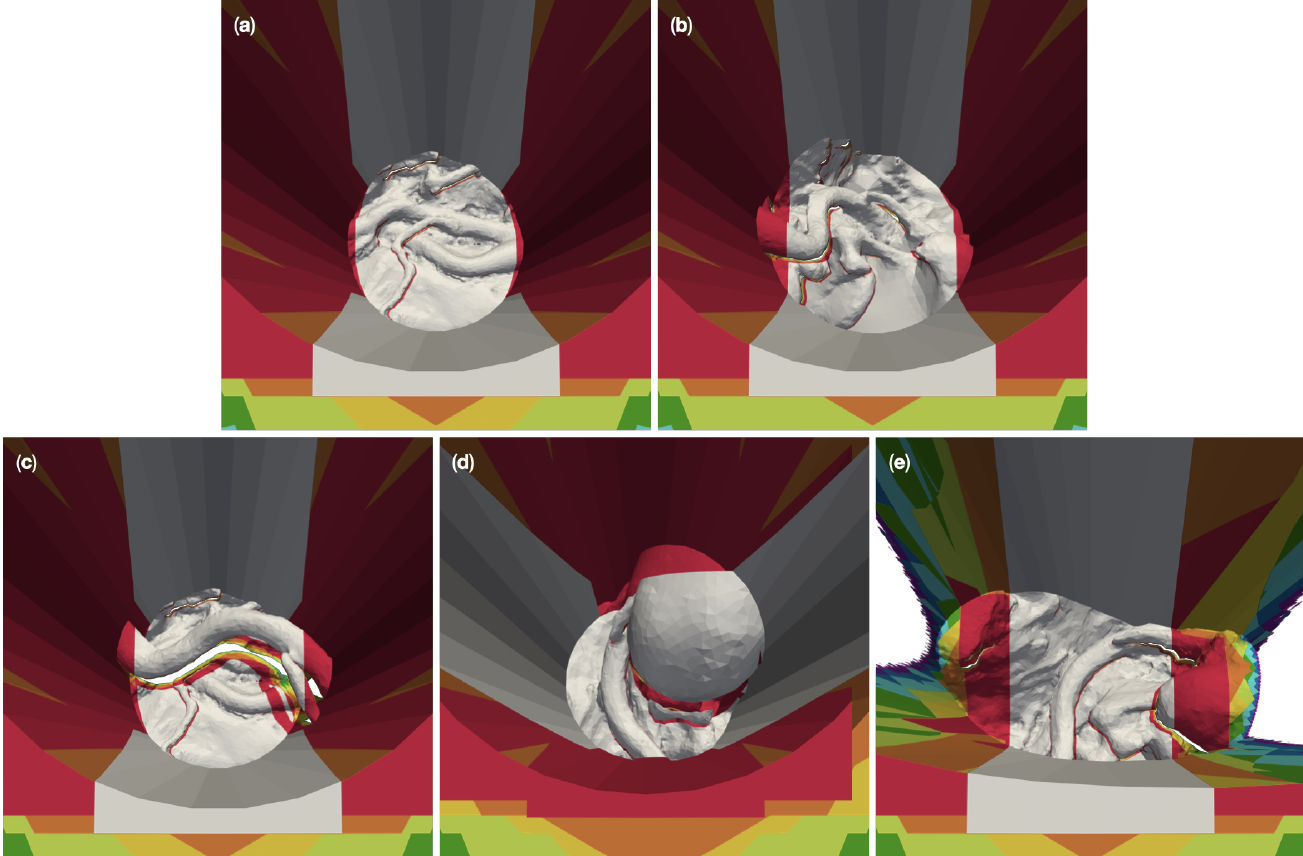
Figure 10. Overlay of zoomed plots of the 3D reconstructable surfaces of the five different 100mm-channel surgical site models for different camera numbers. The reconstruction with the largest area was placed in the background and the reconstruction with the smallest area in the foreground. The areas are color coded by number of cameras: Gray for two cameras, red for four cameras, orange for six, yellow for eight, lime for 16, green for 32, cyan for 64, blue for 128, purple for 256, and magenta for 360. ( a ) shows the reconstruction of “circ flat anatomy”. ( b ) does this for “circ angled anatomy”, ( c ) for “circ artery”, ( d ) for “circ overhang”, and ( e ) for the “elliptical channel”